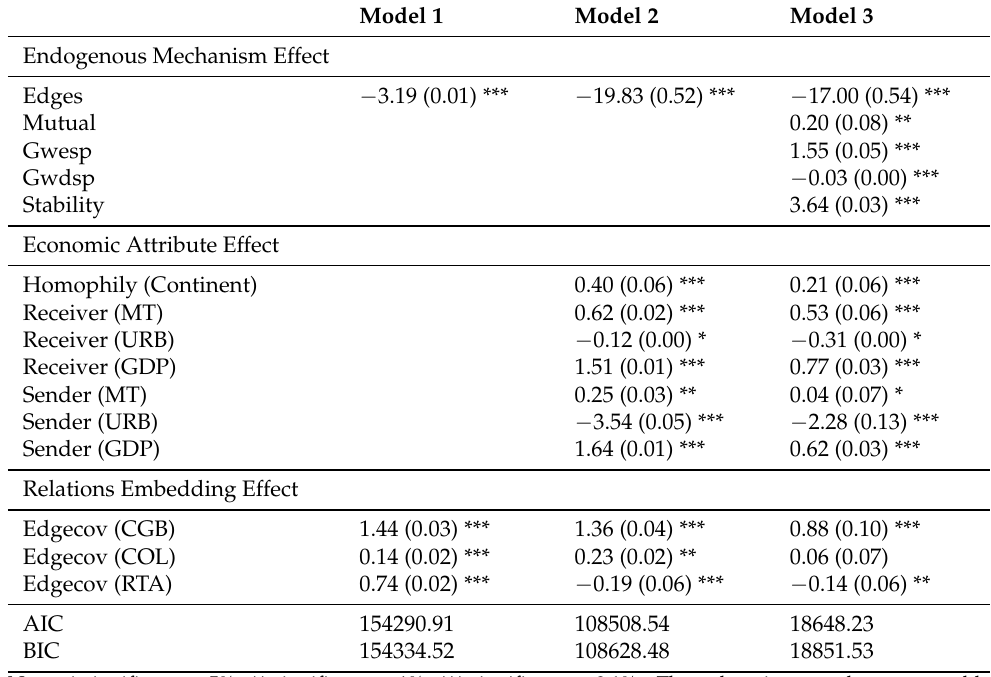
Table 3. Estimation results of TERGM for VWSR transfer networks for the period of